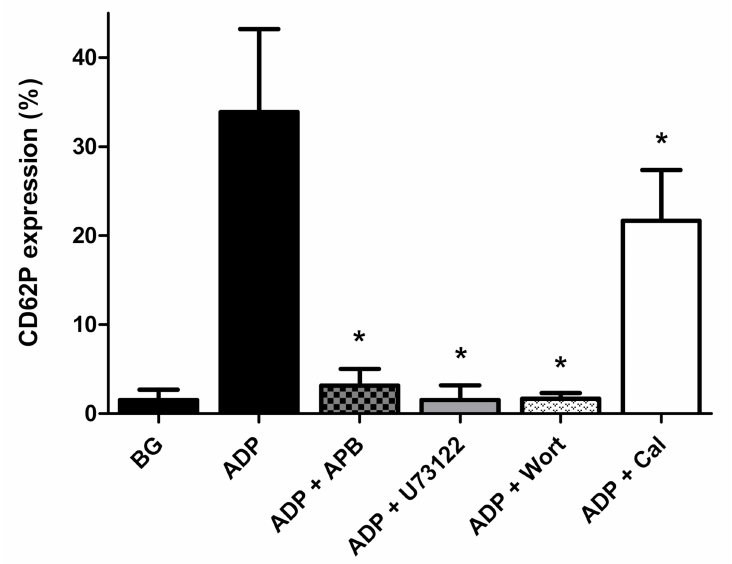
Figure 3. E ff ects of 2-APB (25 µ mol · L − 1 ), U73122 (0.625 µ mol · L − 1 ), wortmannin (Wort, 1 µ mol · L − 1 ) and calmidazolium chloride (Cal, 10 µ mol · L − 1 ) on the magnitude of expression of CD62P on platelets activated with ADP (100 µ mol · L − 1 ). The results are expressed as the mean% activated platelets ± SDs. * p < 0.001– p < 0.0002 for comparison with the drug-free control system. BG = unstimulated platelets ( n = 4 individual donors with 6–18 experiments in each